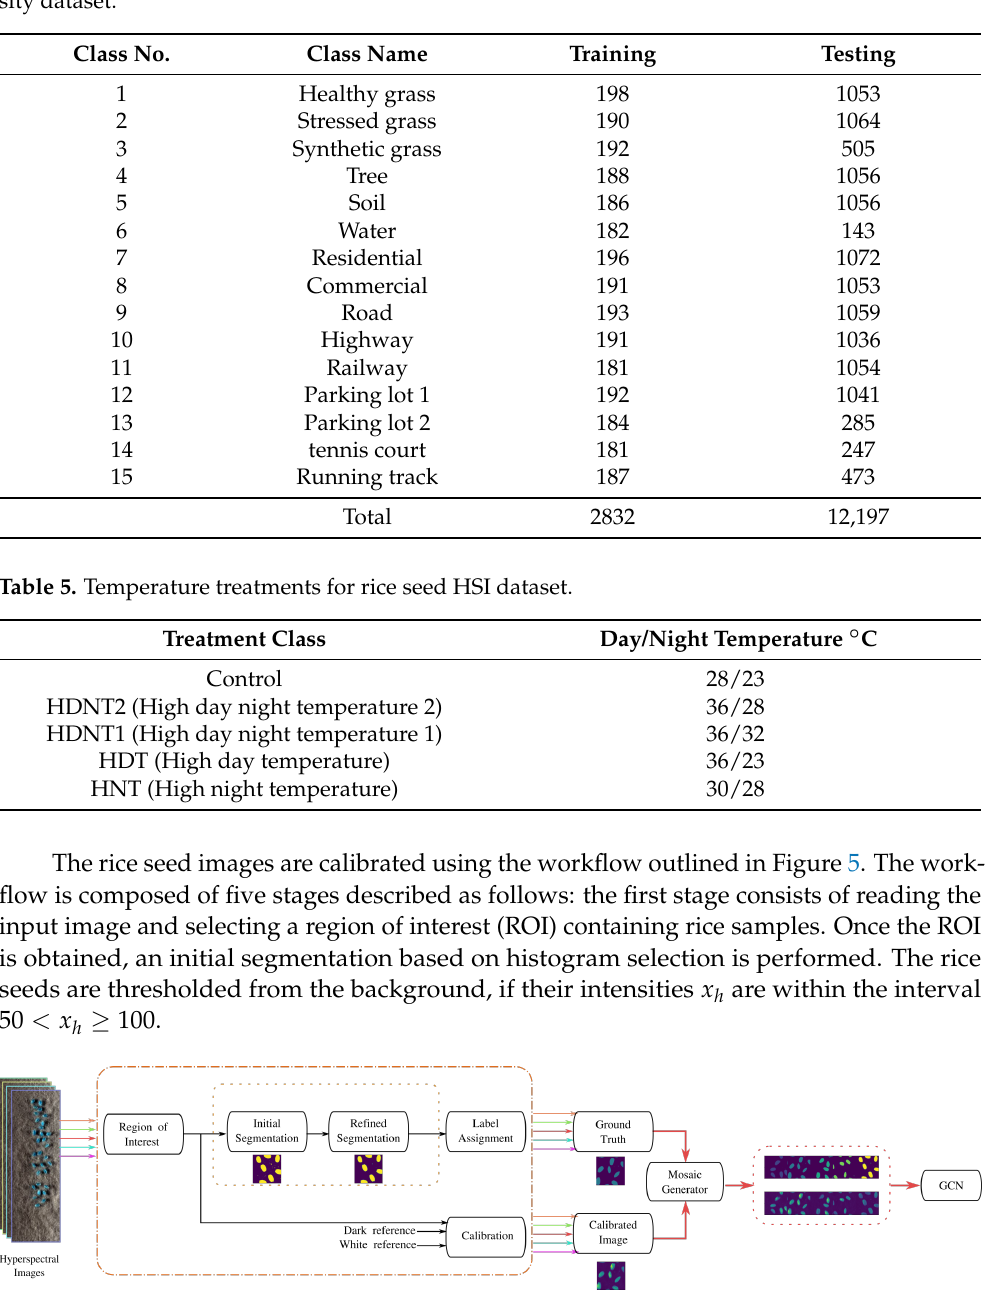
Figure 5. Workflow for preprocessing of rice seed hyperspectral